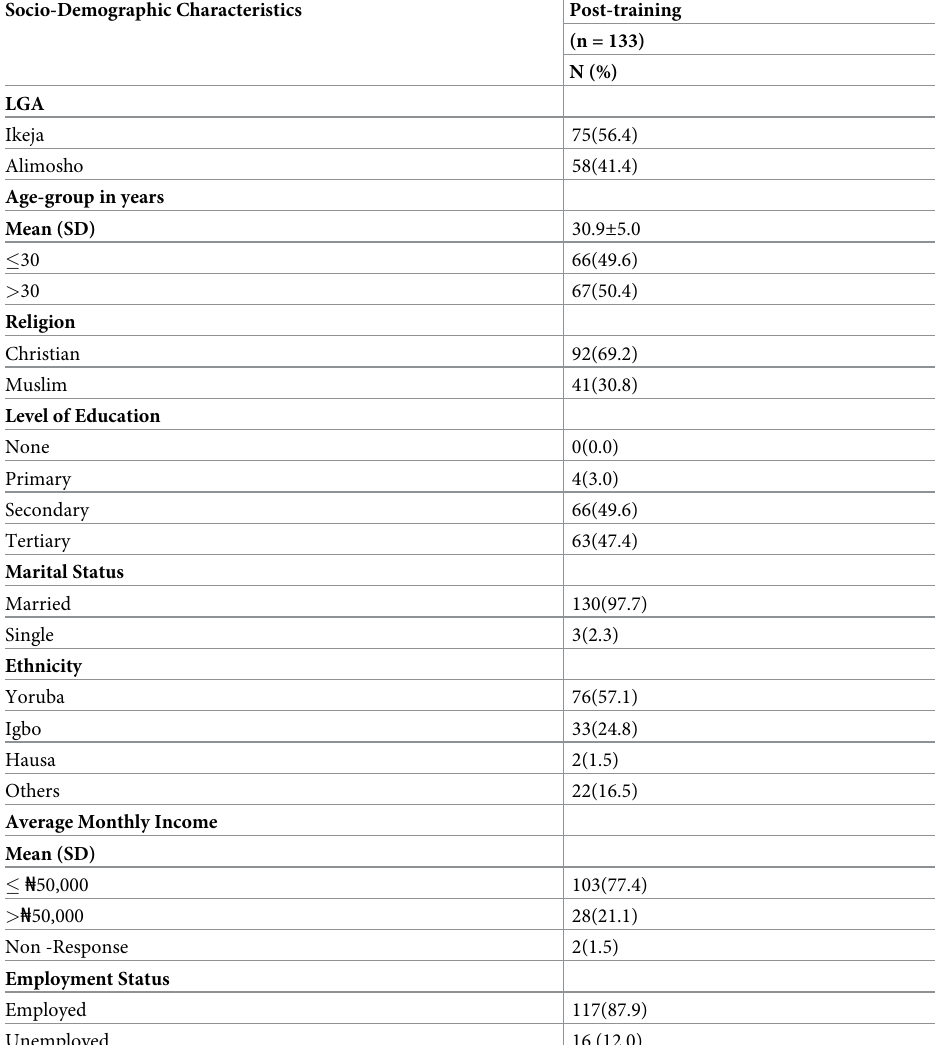
Table 6. Socio-demographic characteristics of